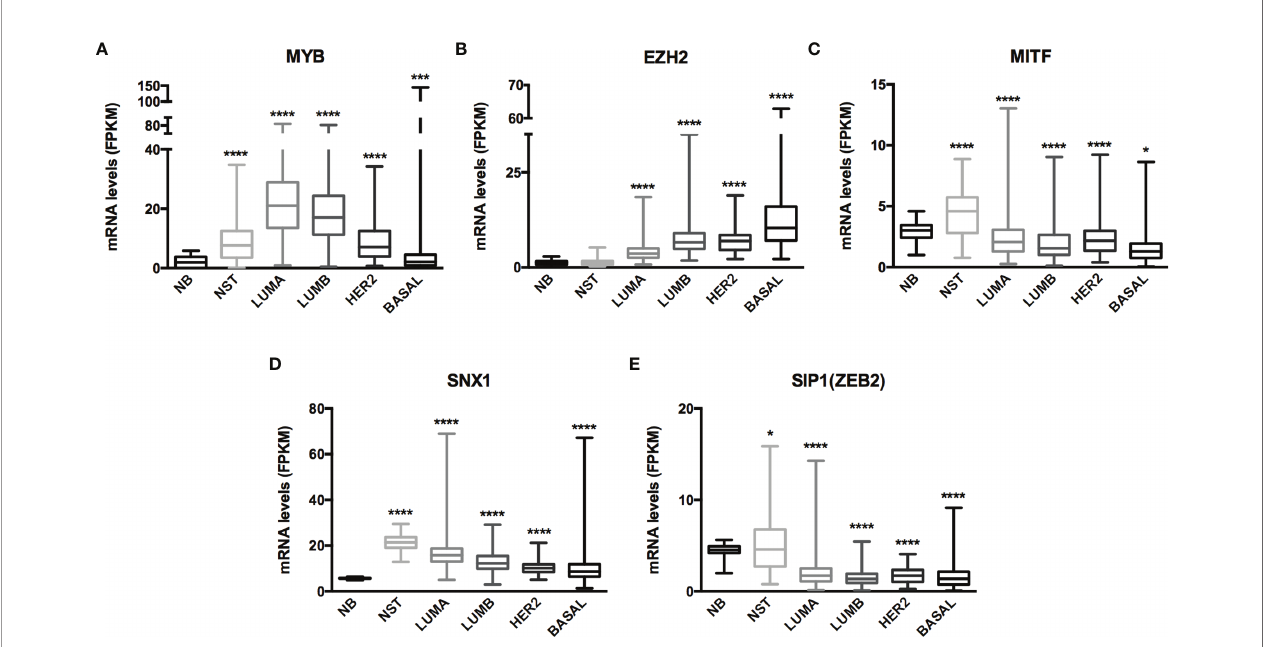
FIGURE 3 | mRNA expression from GTEx and TCGA-BRCA dataset evidenced MYB and EZH2 as miRNome targets. Histogram analysis of miRNAs targets from the GTEx/TCGA-BRCA dataset. We collected (A) MYB , (B) EZH2 , (C) MITF , (D) SNX1 and (E) SIP1(ZEB2) mRNA levels (FKPM) from NB, NST, LUMA, LUMB, HER2 and BASAL subtypes. Statistical differences are related to the NB group. NB, Normal Breast; NST, Normal Solid Tissues. *p < 0.05 and ****p < 0.0001.